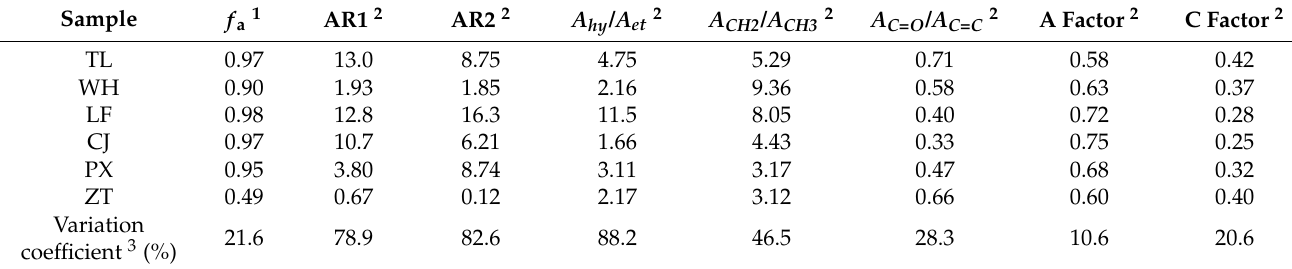
Table 3. Structural parameters determined from FTIR spectra from different geographical loca- tions. Variation coefficient indicates the differences among weathered coal samples from different geographical